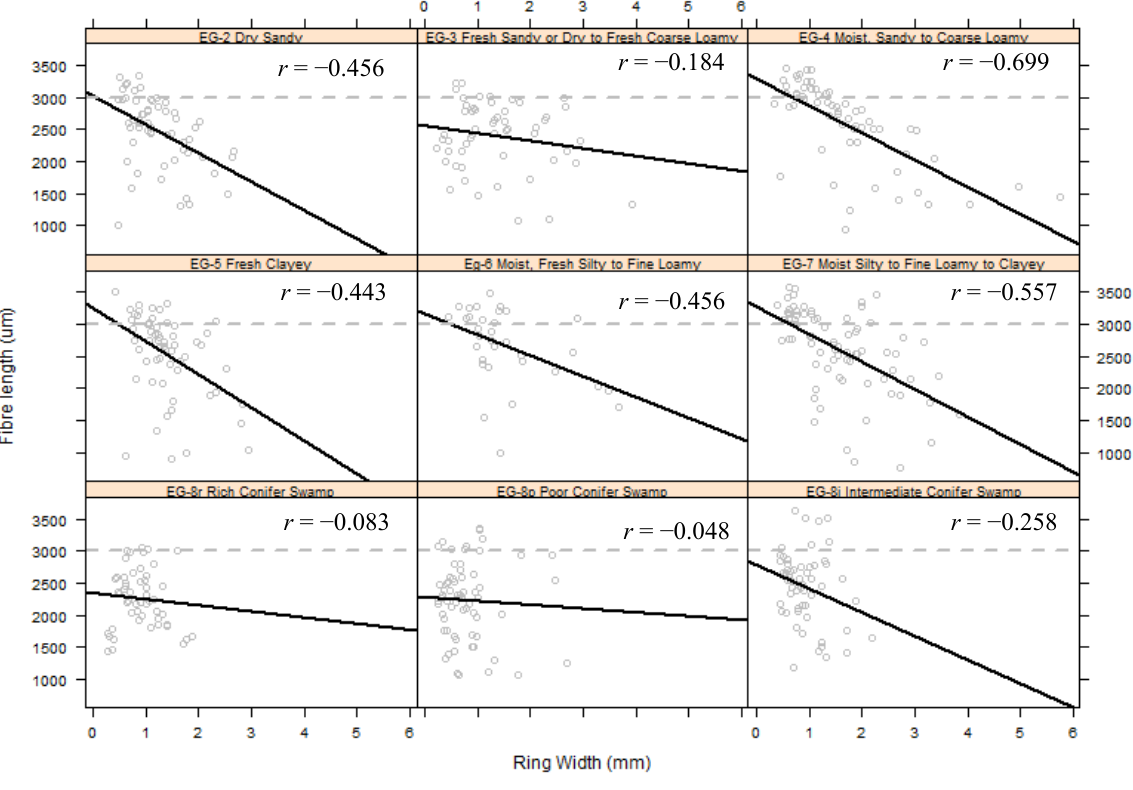
Figure 6. Scatterplot of mean fibre length (combined earlywood and latewood) and ring width for black spruce increment cores representing different ecosite groups collected from the boreal forest of north eastern Ontario from 2010–2011. r = Pearson correlation